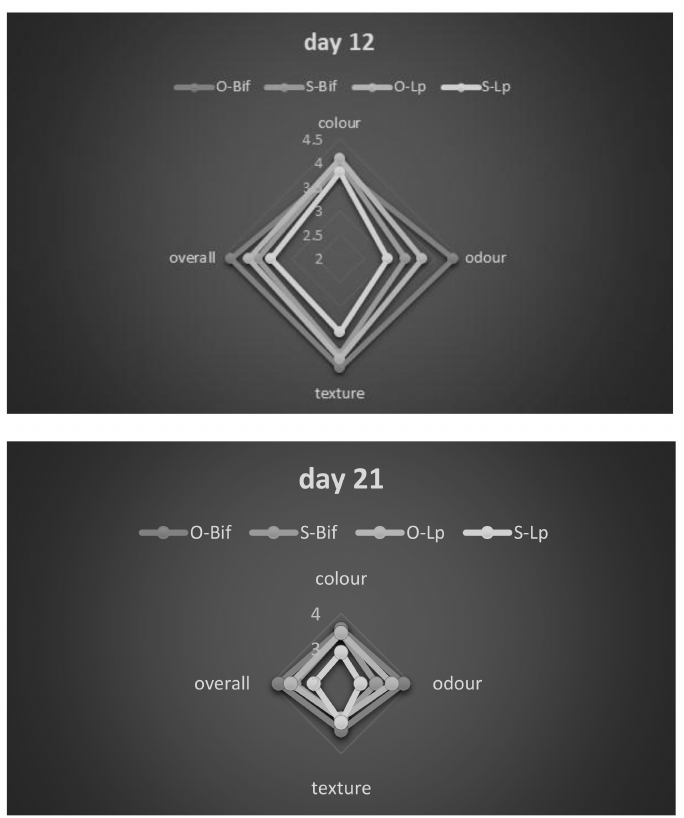
Figure 8. Spider graphs at days 12 and 21. O, products in sunflower oil; S, products in diluted brine; Lp, product inoculated with L. plantarum 69; Bif, product inoculated with B. animalis